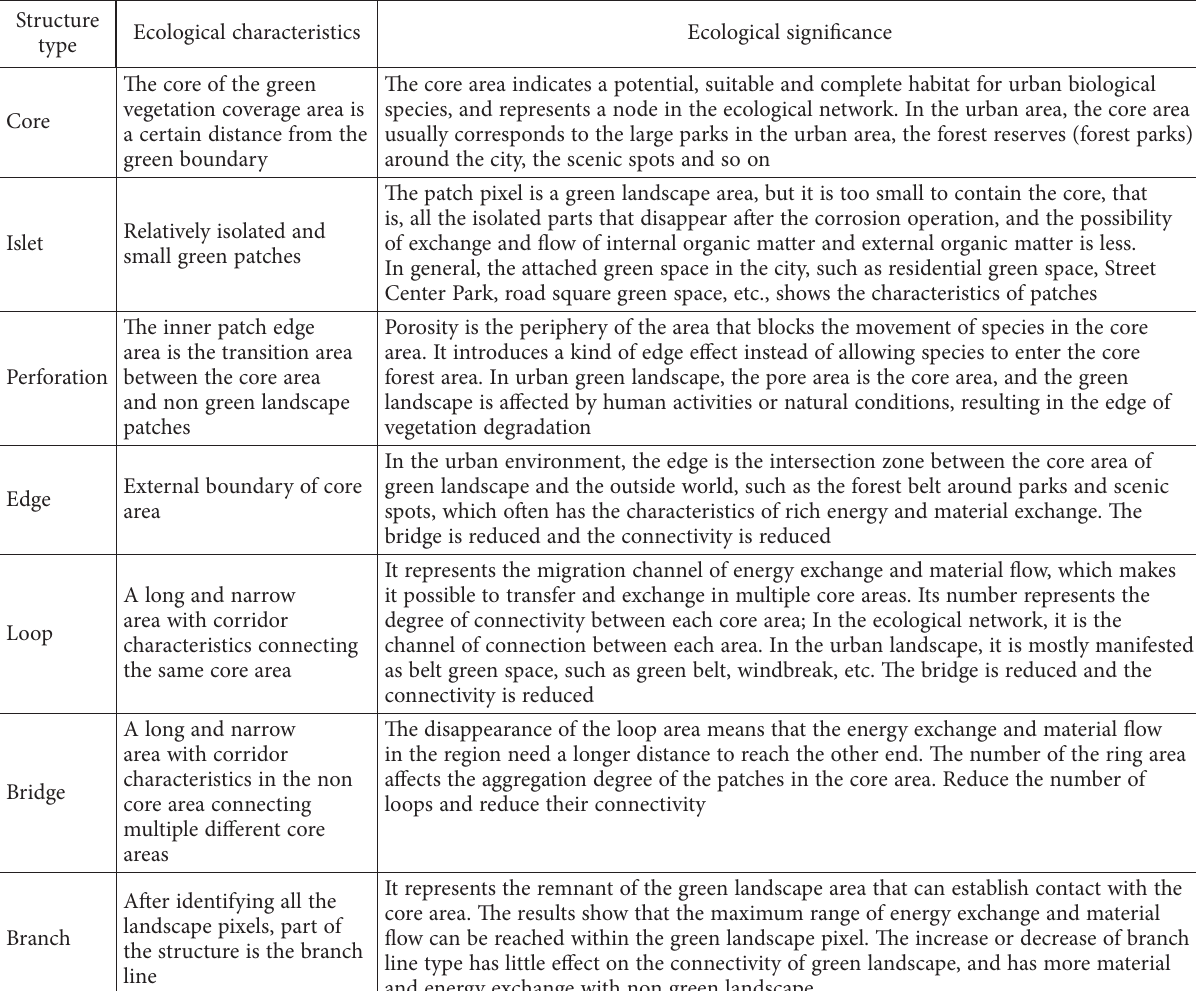
Table 1. Types of morphological spatial pattern